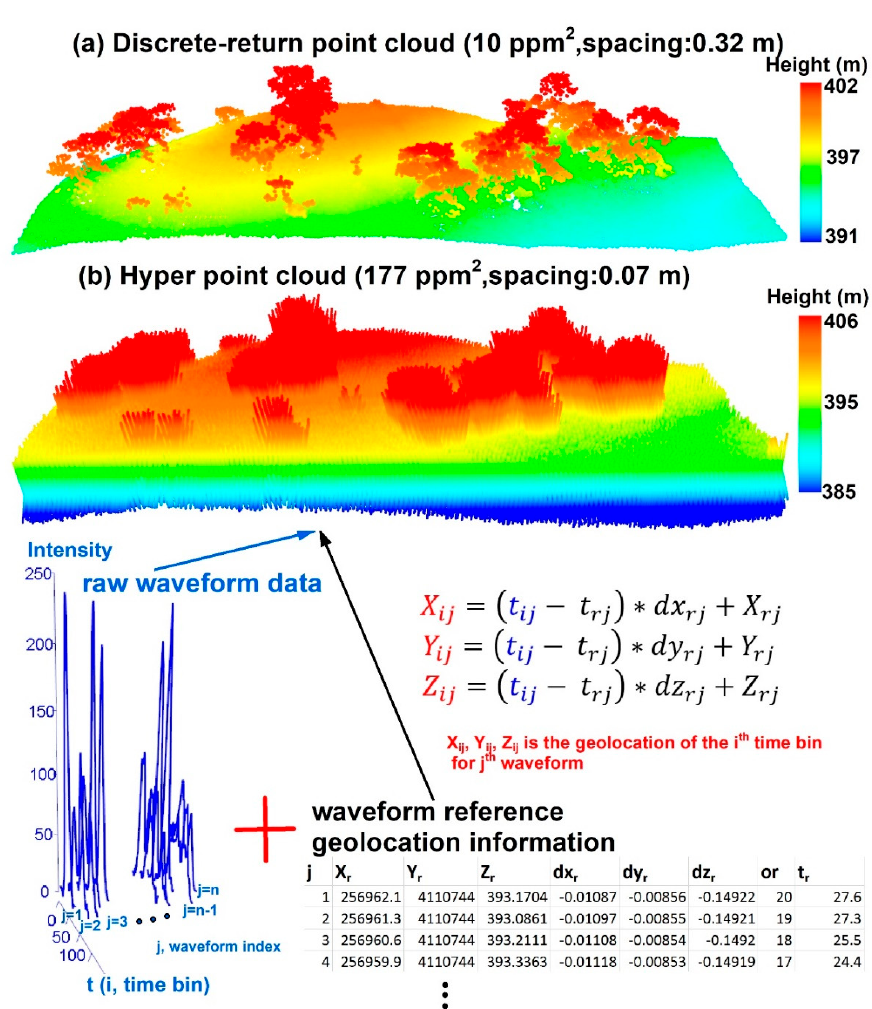
Figure 3. Comparison of the discrete-return LiDAR point cloud and the hyper point cloud (HPC) over the same subset region. ( a ) Discrete-return LiDAR point cloud. ( b ) Illustration of the HPC generation process by combing raw waveform data (blue) and corresponding waveform reference geolocation information (black).